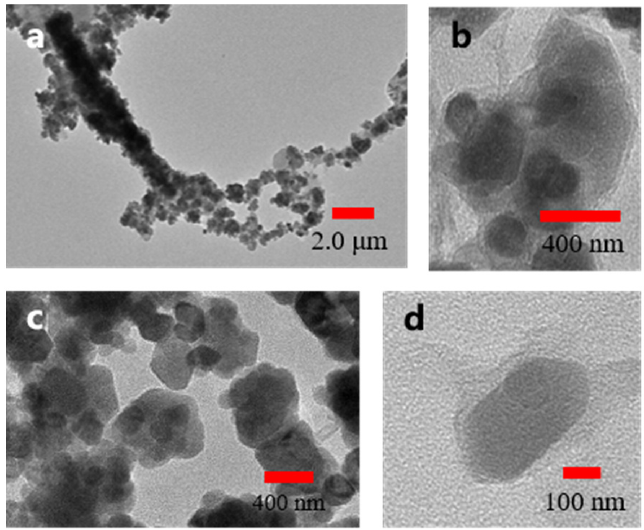
Figure 2. Transmission electron microscopy images of Fe 3 O 4 @rGO nanoparticles at variable magnifications ( a–d ).